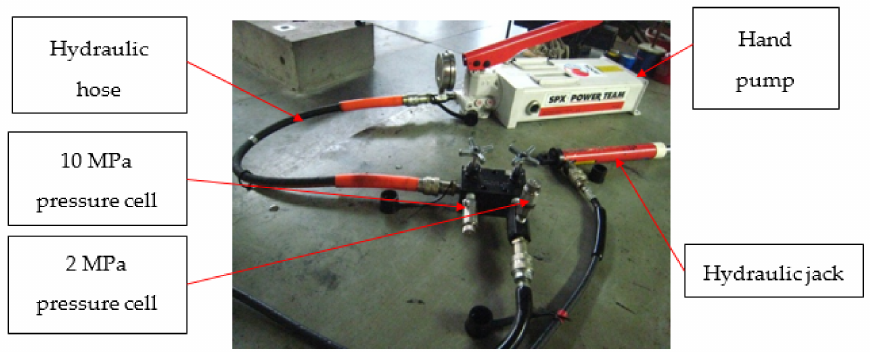
Figure 15. Hydraulic pump, hoses and pressure cells.